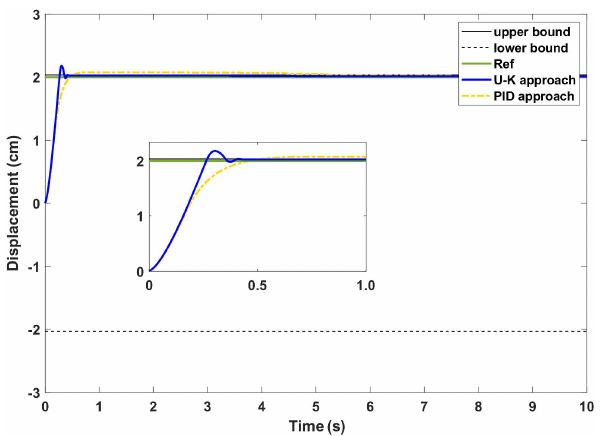
Figure 8. Experimental error of the transient performance of U–K and PID.